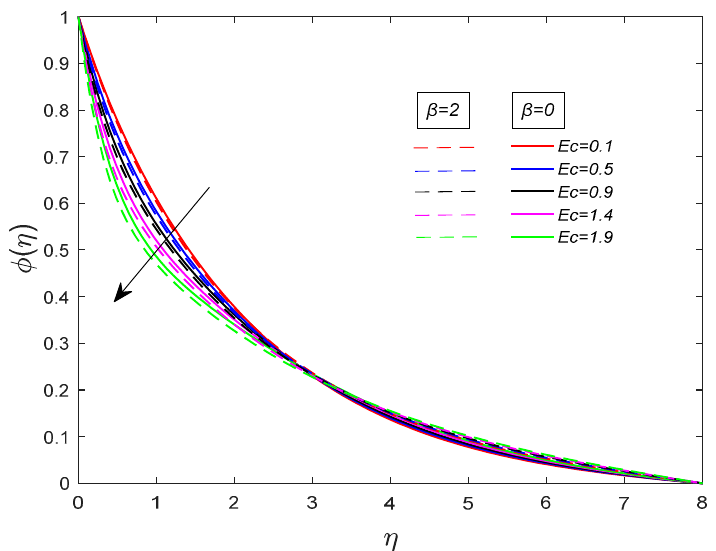
Figure 11. Effect of the Eckert number (Ec) on concentration profile with Pr = 0.7, M = Kr = Sc = 0.5, Sr = 1.5.